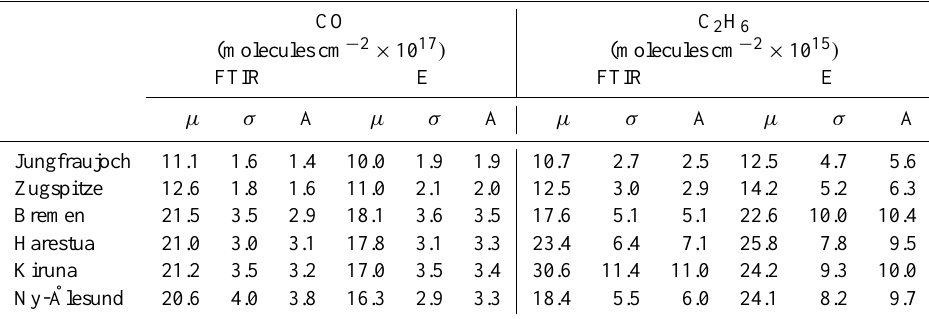
Table 4. Average values ( µ) , standard deviations ( σ) and seasonal amplitudes (A) from the FTIR measurements and European-scale model (E). A is the difference between the average values of March and April and July to September.